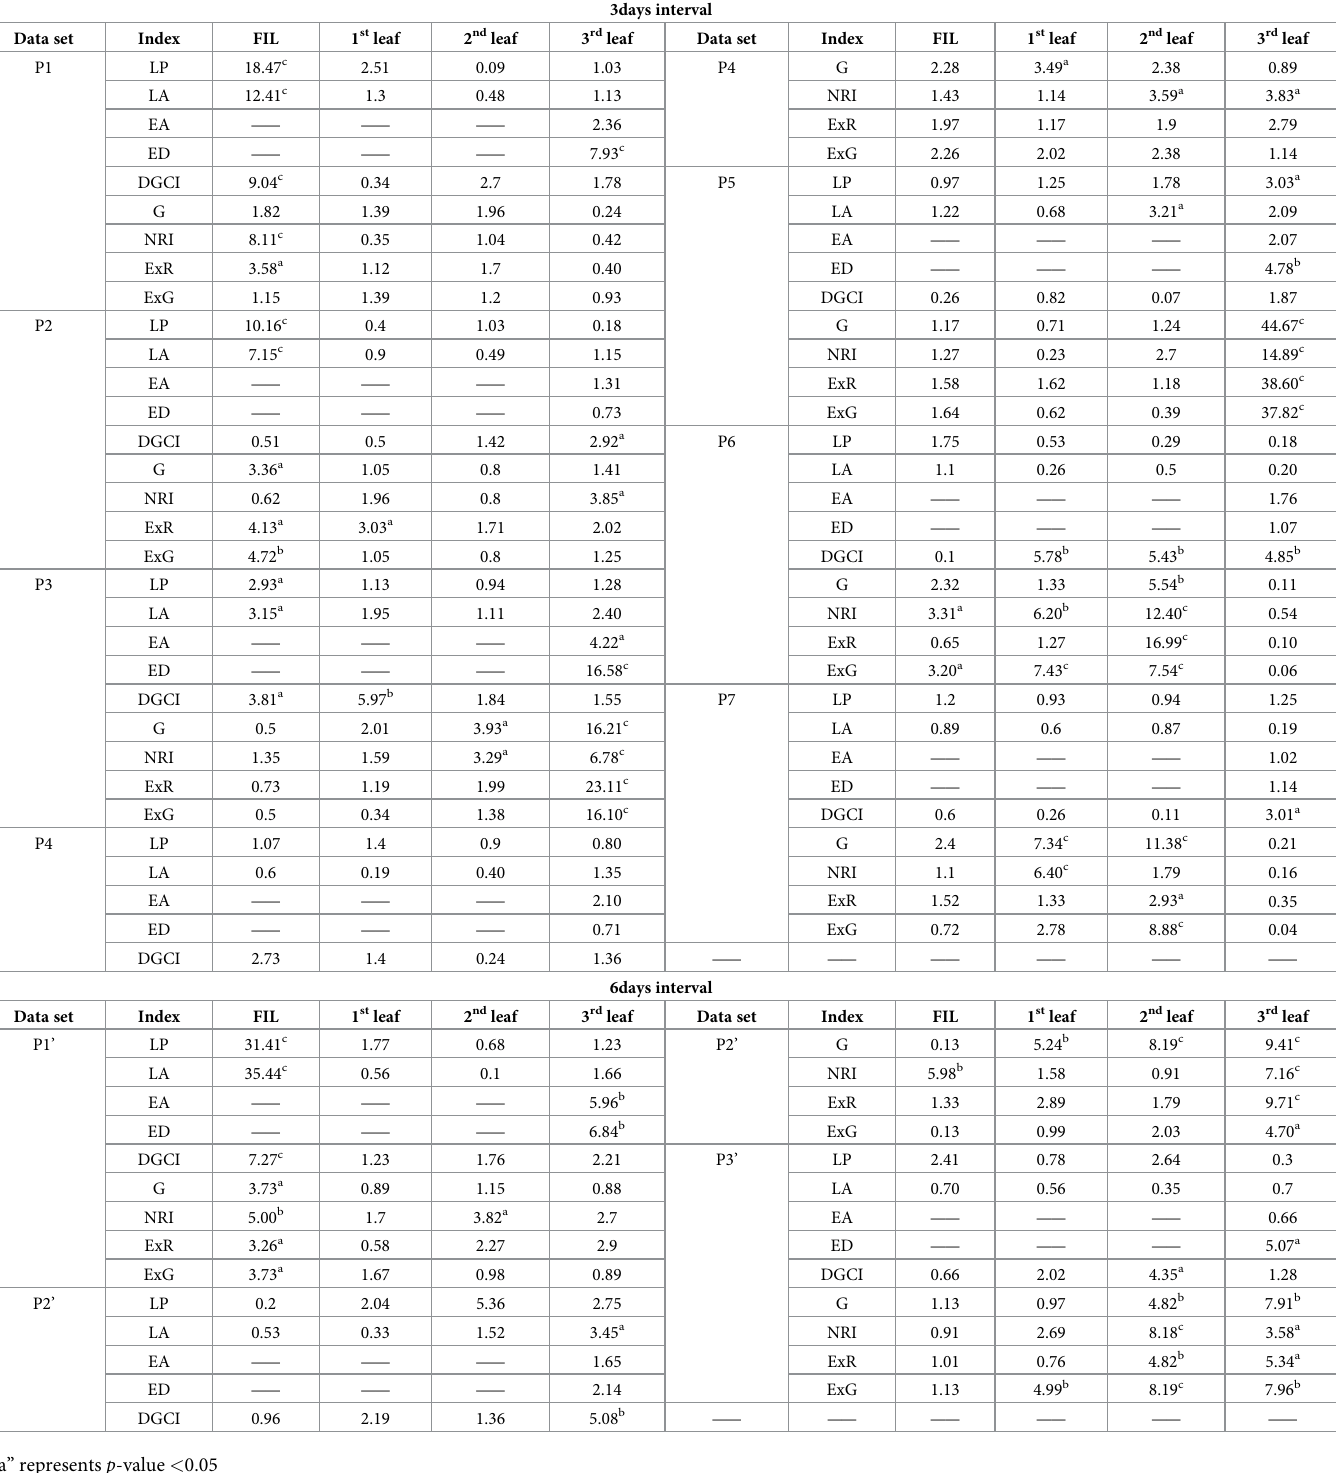
Table 4. F value of rice leaf characteristic parameters using ANOVA.